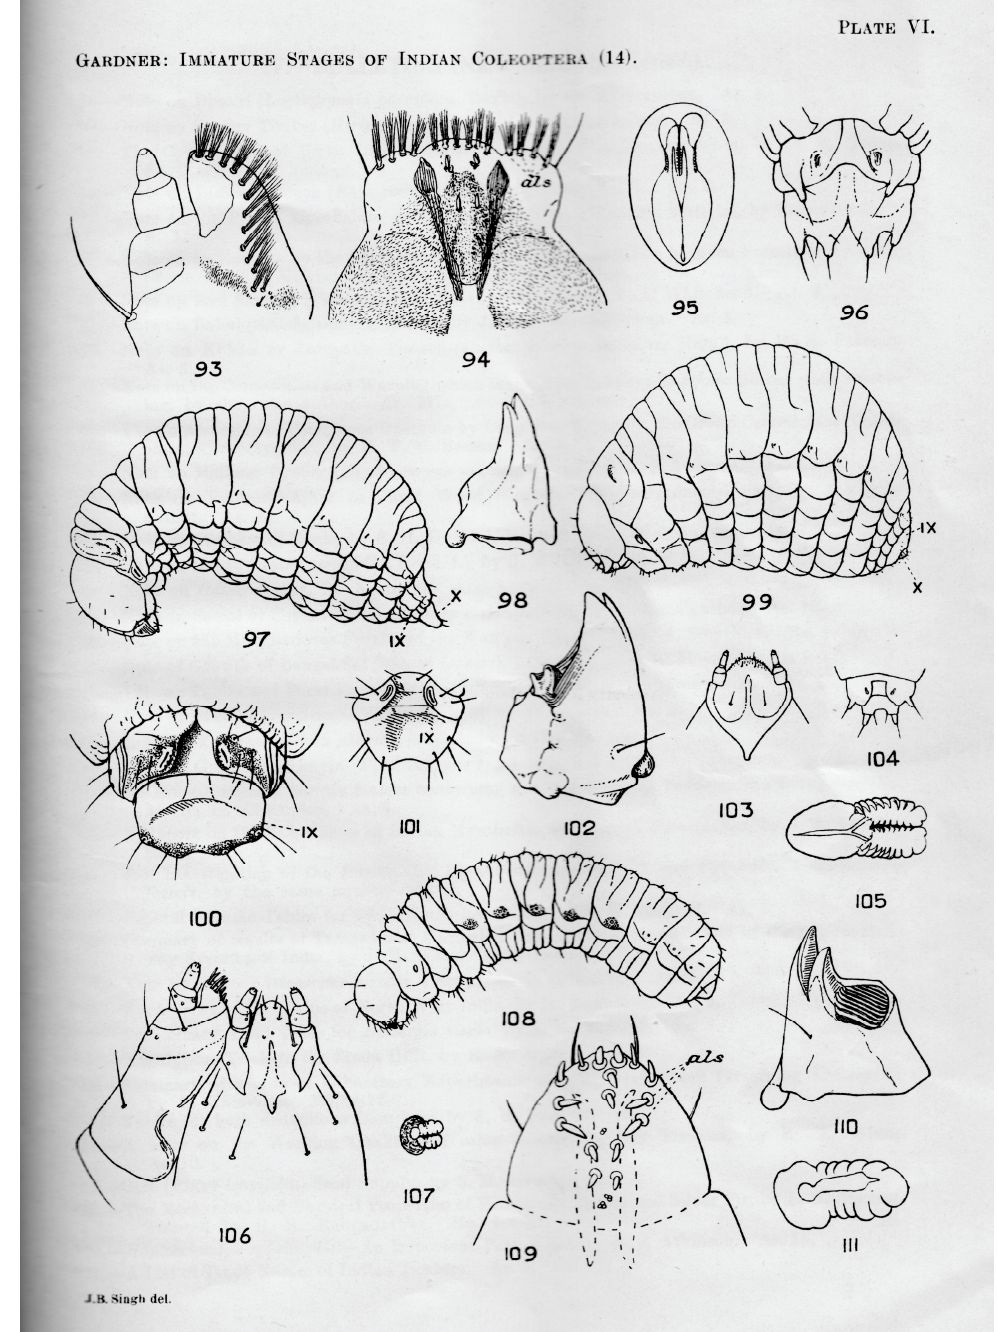
Figure 91. Reproduction of Gardner ([11], 48) Plate VI: “Larvae of Curculionidae. Figures 93–96. Sipalus [ Sipalinus ] hypocrita Boh. 93. Maxillary mala, dorsal view. 94. Epipharynx. 95. Abdominal spricale. 96. Posterior extremity, dorsal view. Figures 97 and 98. Cyrtotrachelus longipes F. 97. Lateral view. 1 98. Mandible. Figure 99. Calandra [ Sitophilus ] rugicollis Casey. Figure 100. Rhynchophorus ferrugienus Ol., posterior extremity in dorsal view. Figures 101 and 102. Odoiporus longicollis Ol. 101. Posterior extremity in dorsal view. 102. Mandible. Figures 103–105. Xerodermus himalayanus Mshl. 103. Labium. 104. Posterior extremity in dorsal view. 105. Spiracle. Figures 106–110. Cossonus binodosus Mshl. 106. Ventral mouthparts. 107. Abdominal spiracle. 108. Lateral view. 109. Epipharynx. 110. Mandible. Figure 111. Brachydemnus himalayensis Stebb., an abdominal spiracle. 1 In Figure 97 the numerals IX and X should have been interchanged.”